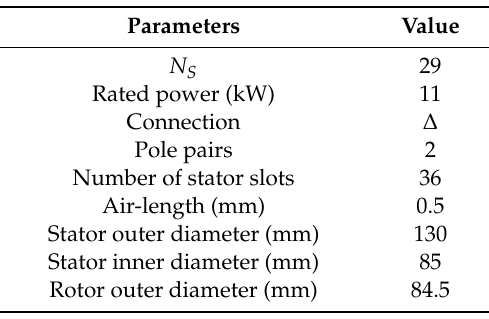
Table 1. Basic parameters of the prototype.